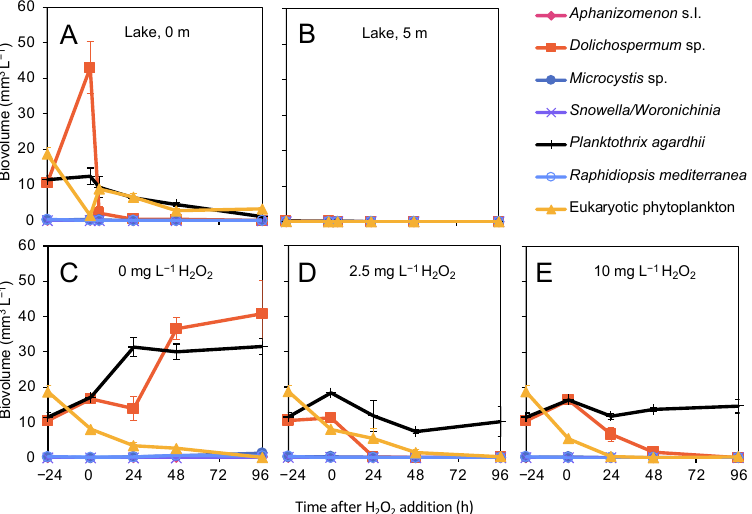
Figure 3. Phytoplankton composition during the H 2 O 2 treatment in August. ( A , B ) Biovolume of the most abundant cyanobacterial taxa and of the total eukaryotic phytoplankton at ( A ) the 0-m and ( B ) 5-m depth during the H 2 O 2 treatment of the lake in August. ( C – E ) Biovolumes in the incubation experiments treated with ( C ) 0 mg L − 1 , ( D ) 2.5 mg L − 1 and € 10 mg L − 1 of H 2 O 2 . The data show the mean ( ± SD) of n = three biological replicates per time